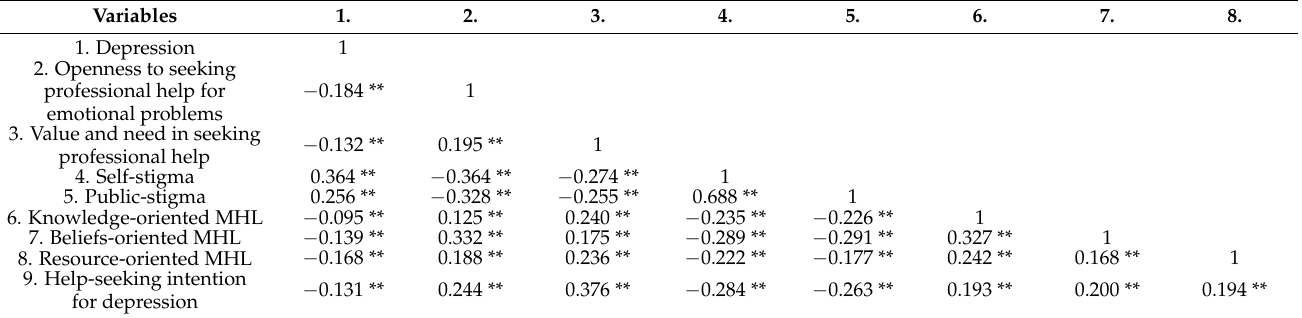
Table 3. Correlations between depression, help-seeking attitude, stigma, mental health literacy, and help-seeking intention for depression ( n =